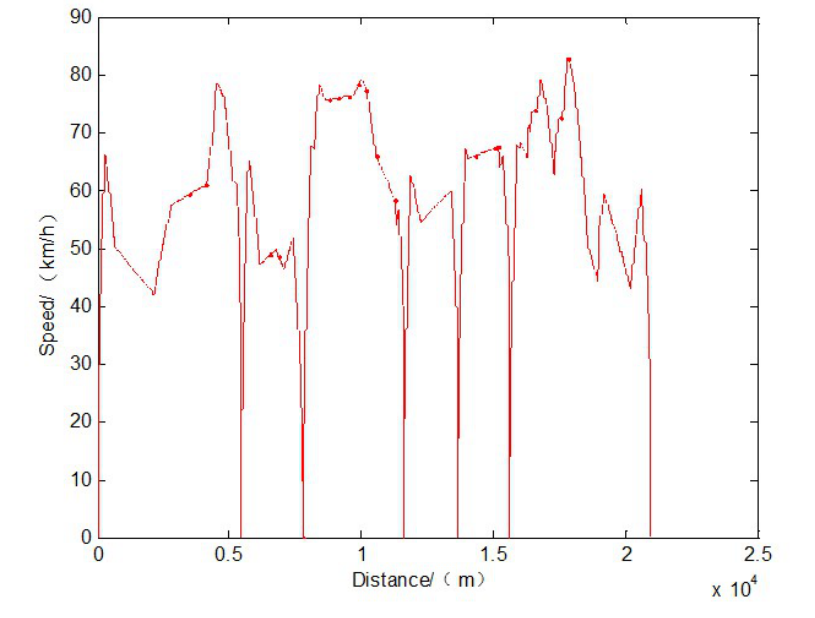
Figure 12. The optimal speed